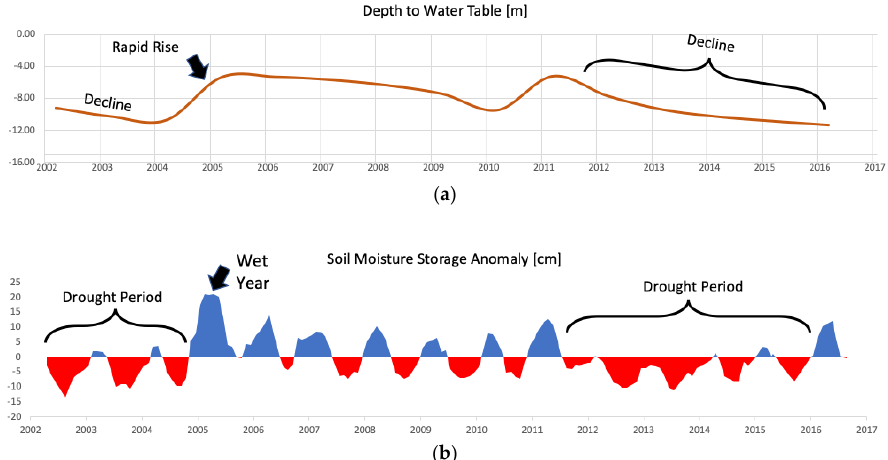
Figure 2. Correlation between soil moisture and groundwater levels near Beryl, Utah: ( a ) Depth to Groundwater at Well 37349113434201 near Beryl, Utah; ( b ) Soil Moisture Liquid Water Equivalent Thickness Simulated by GLDAS near Beryl, Utah showing the lag between high soil moister in late 2004–2005 and a corresponding increase in the groundwater level in early